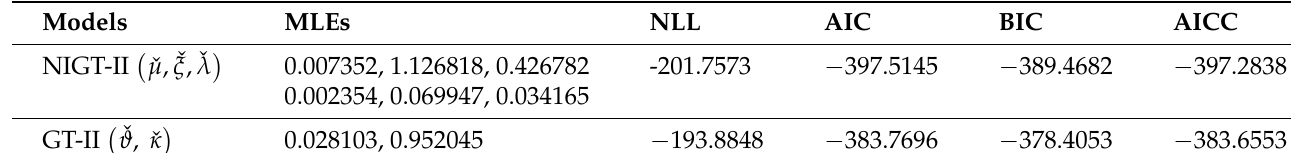
Table 5. Statistical outcomes of NIGT-II and GT-II models for the second data.